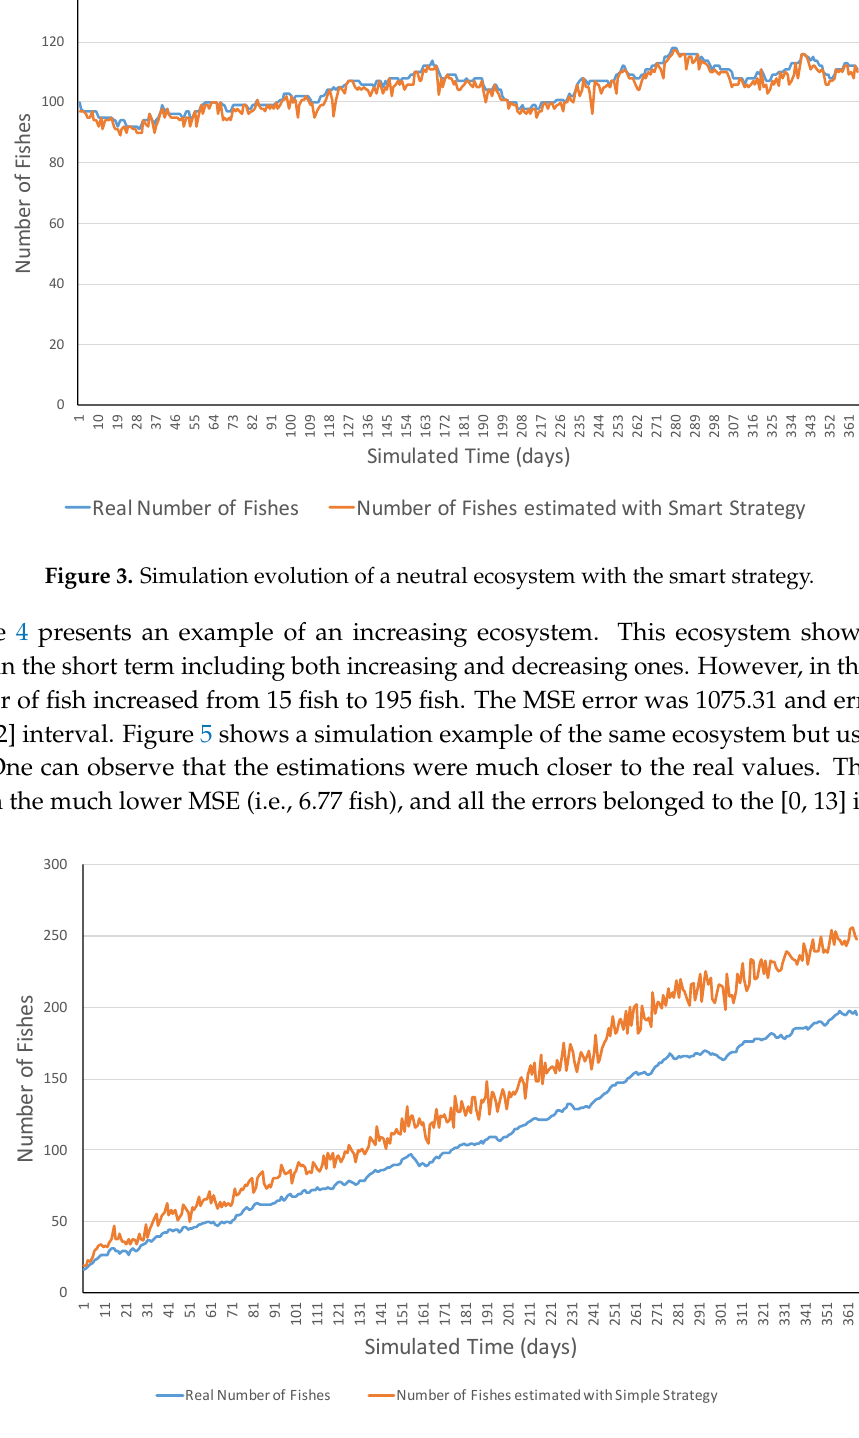
Figure 4. Simulation evolution in an increasing ecosystem with the simple